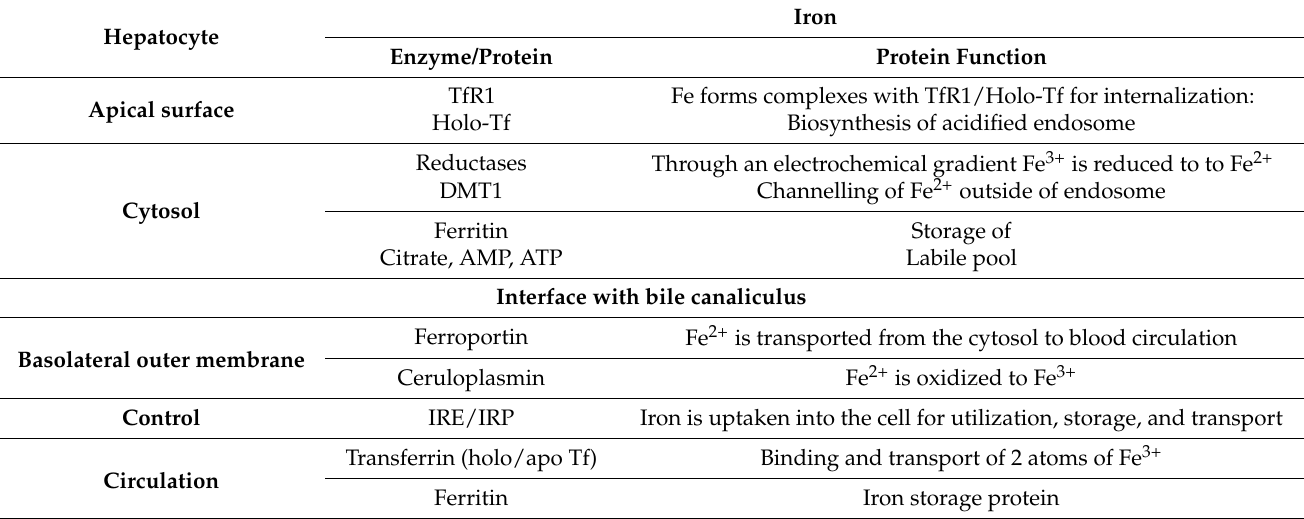
Table 2. Iron metabolism in the